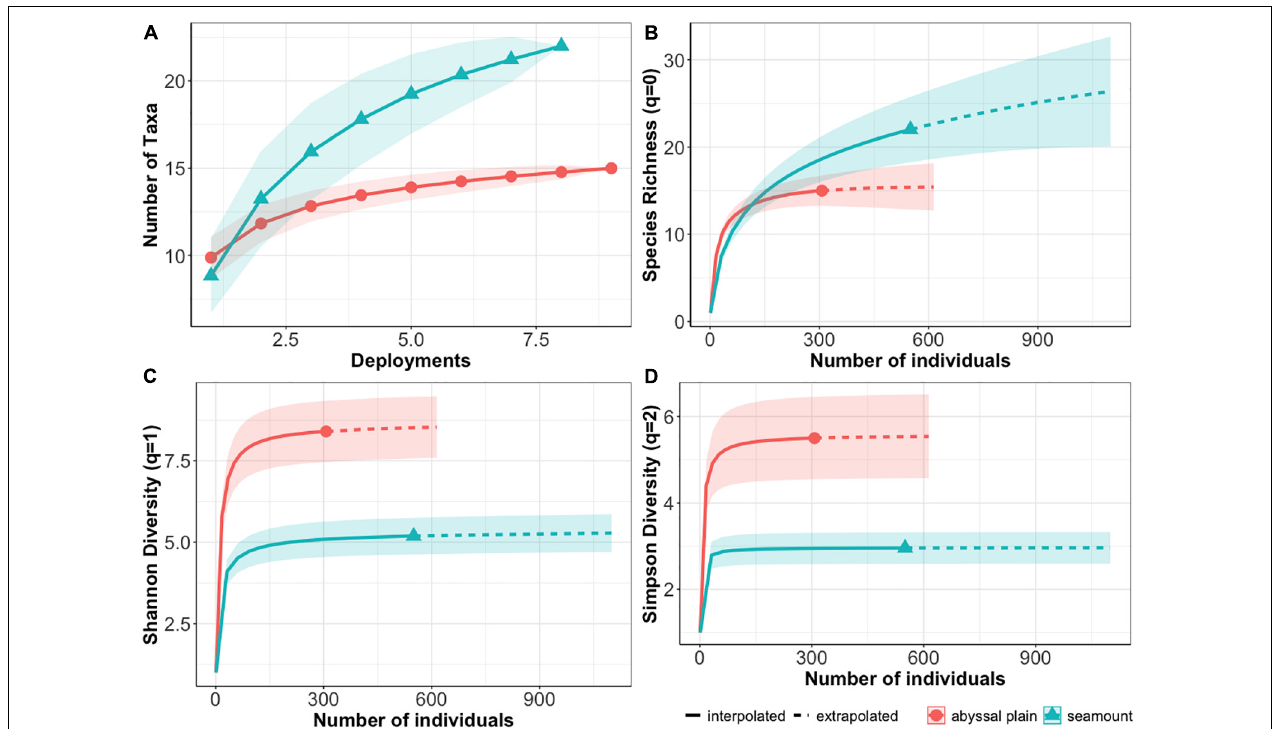
FIGURE 4 | Comparisons of sampling effort and diversity metrics between seamounts (blue triangle) and abyssal plains (red circle). (A) Morphospecies accumulation curves by habitat type. (B) Species richness (Hill number q = 0), (C) Shannon diversity (Hill number q = 1) and (D) Simpson Diversity (Hill number q = 2) with 95% confidence intervals (CI) (shaded areas) for each habitat type. For panel (B–D) interpolated values are shown with solid lines and extrapolated values with dashed